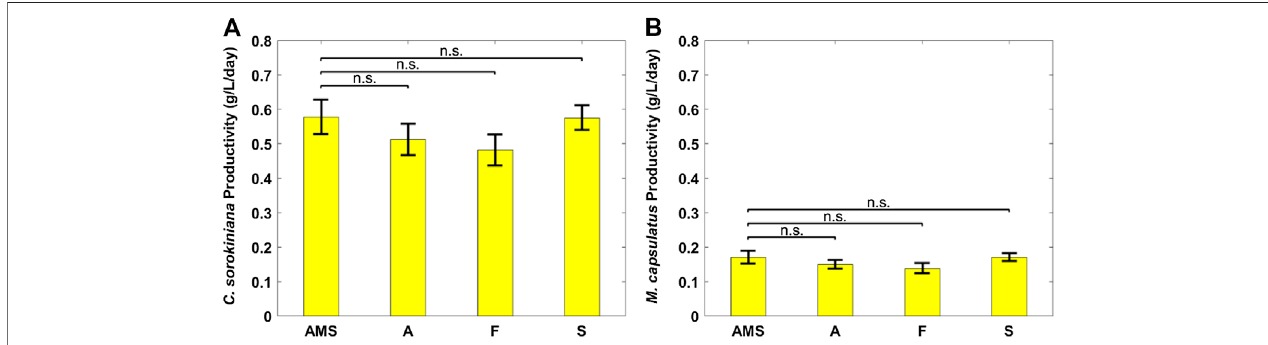
FIGURE 6 | Biomass productivity of individual coculture strains on differently pretreated anaerobic digestion ef fl uent diluted by clari fi er ef fl uent: (A) Chlorella sorokiniana and (B) Methylococcuscapsulatus .TheDunnett ’ stest,withammoniummineralsalts(AMS)asthecontrol,indicatesthatthesedifferencesarenotsigni fi cant (n.s.) statistically at signi fi cance level α (cid:2) 0.05.